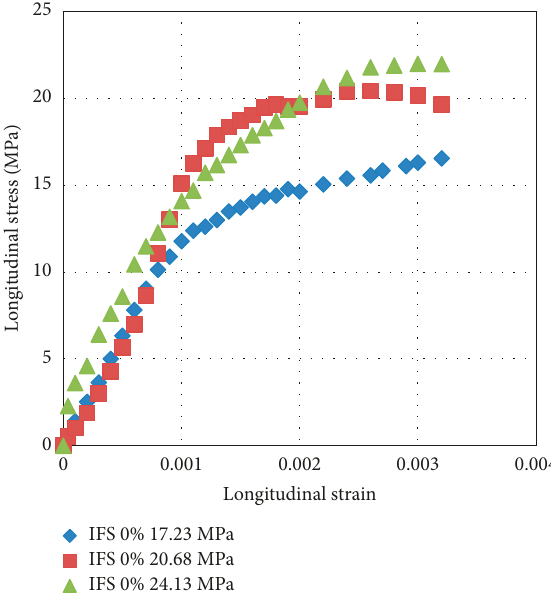
Figure 18: Longitudinal stress-strain diagram of 100% RAC.